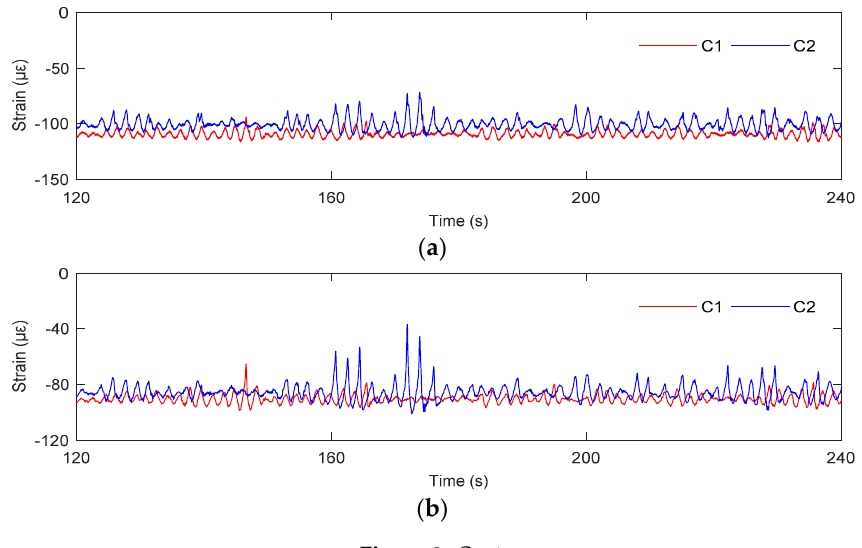
Figure 8. The structural strains at various measurement positions in waves. ( a ) Variation with wave height when wave period T = 1.6 s; ( b ) Variation with wave period when wave height H = 0.15 m.